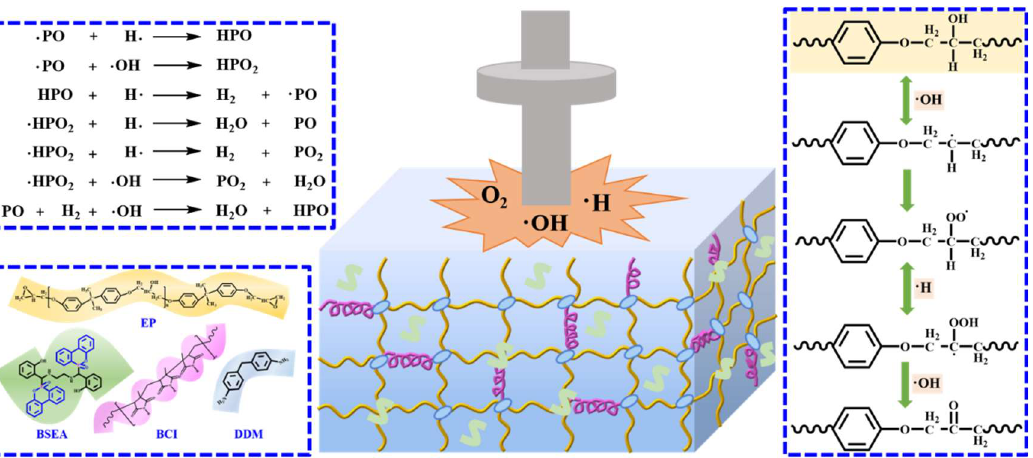
Figure 6. Liquid oxygen compatibility mechanism of the BSEA-modified EP.